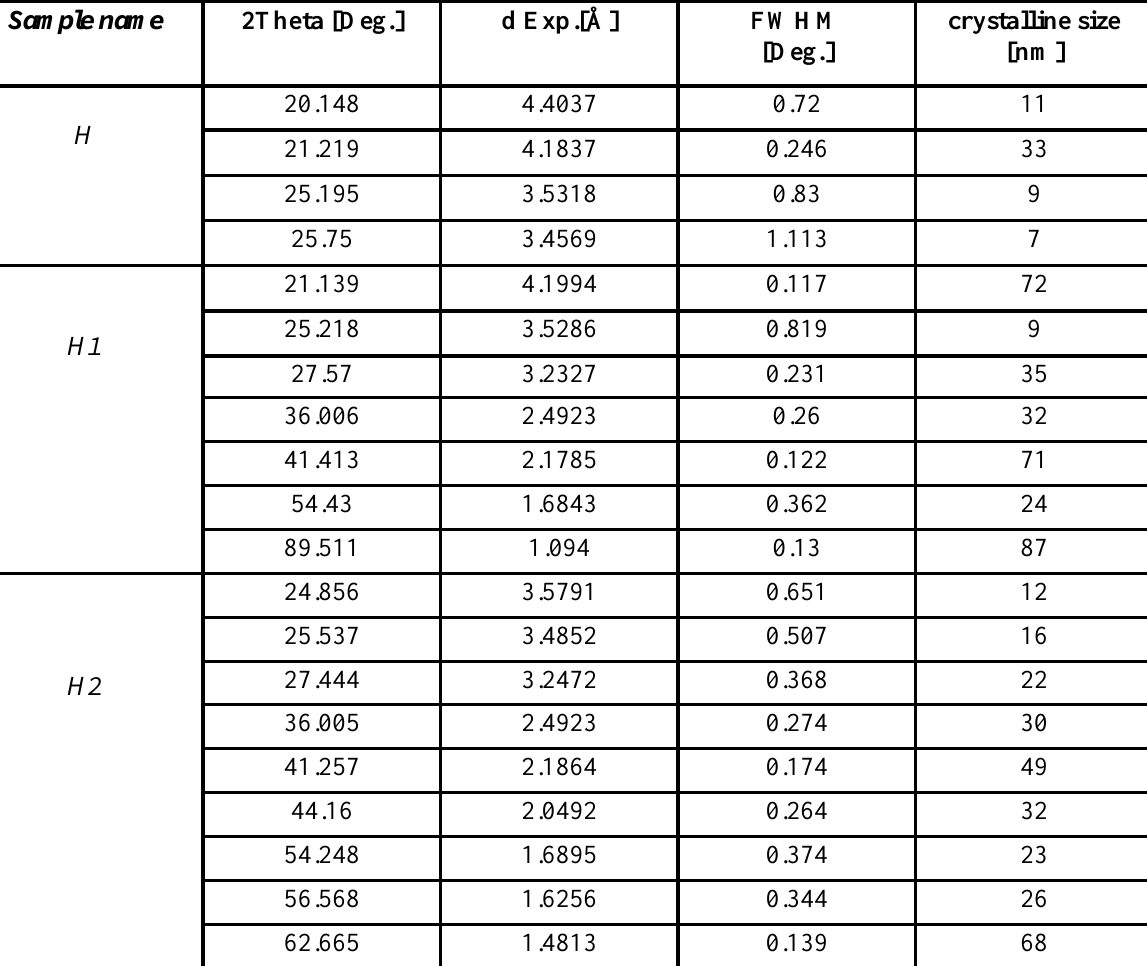
SO (H , PANITNCs 2 4